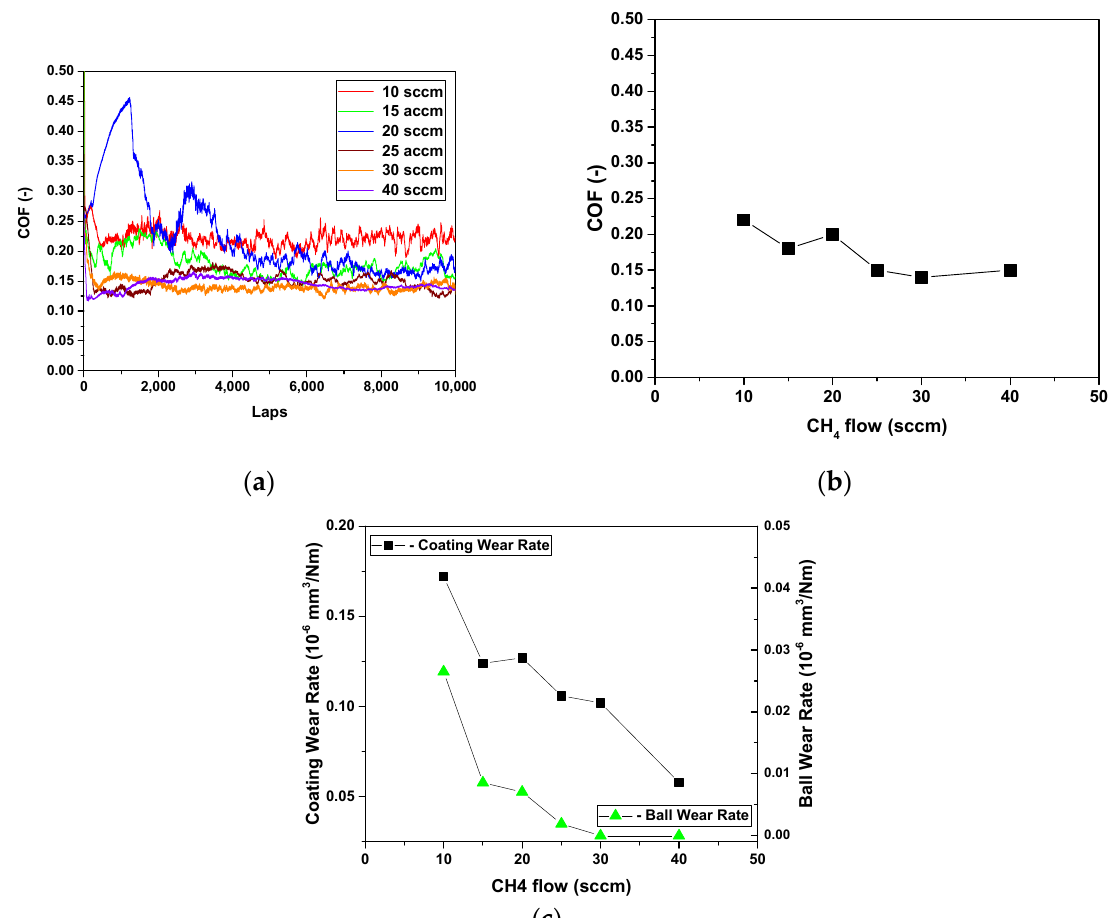
Figure 7. Tribological characterization of the coatings: ( a ) coefficient of friction (COF) plots for all coatings, ( b ) evolution of the average COF with the increase in the CH 4 flow, ( c ) coating and ball-wear rate with the increase in the CH 4 flow.